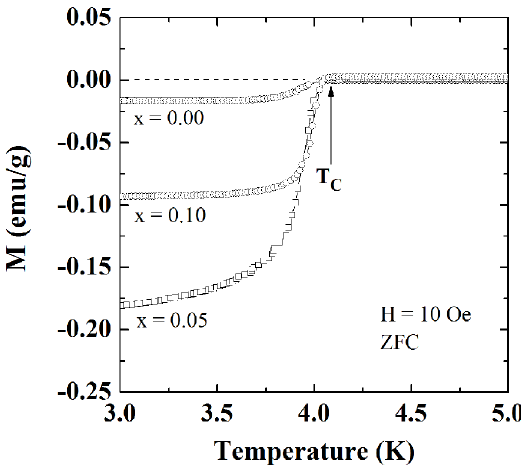
Figure 8. Magnetization as a function of temperature in ZFC situation at H = 10 Oe for samples with x = 0.00, x = 0.05 and x =